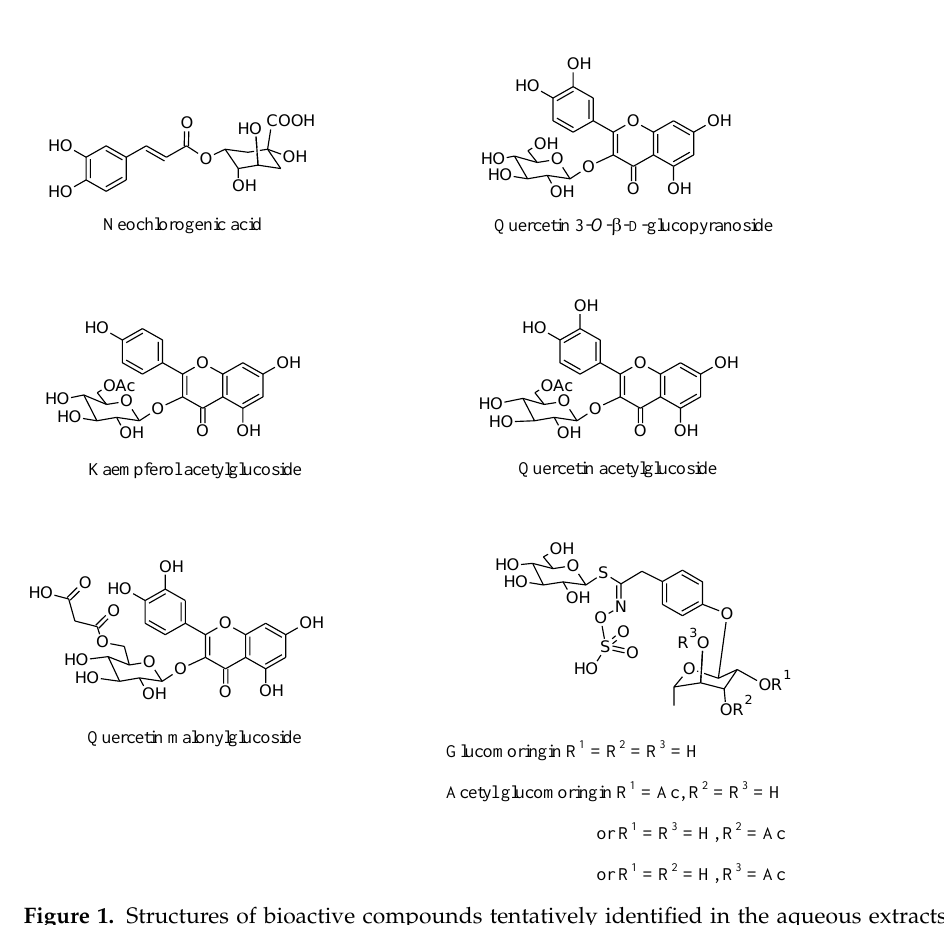
Figure 1. Structures of bioactive compounds tentatively identified in the aqueous extracts of M. oleifera leaves (Tables 1 and